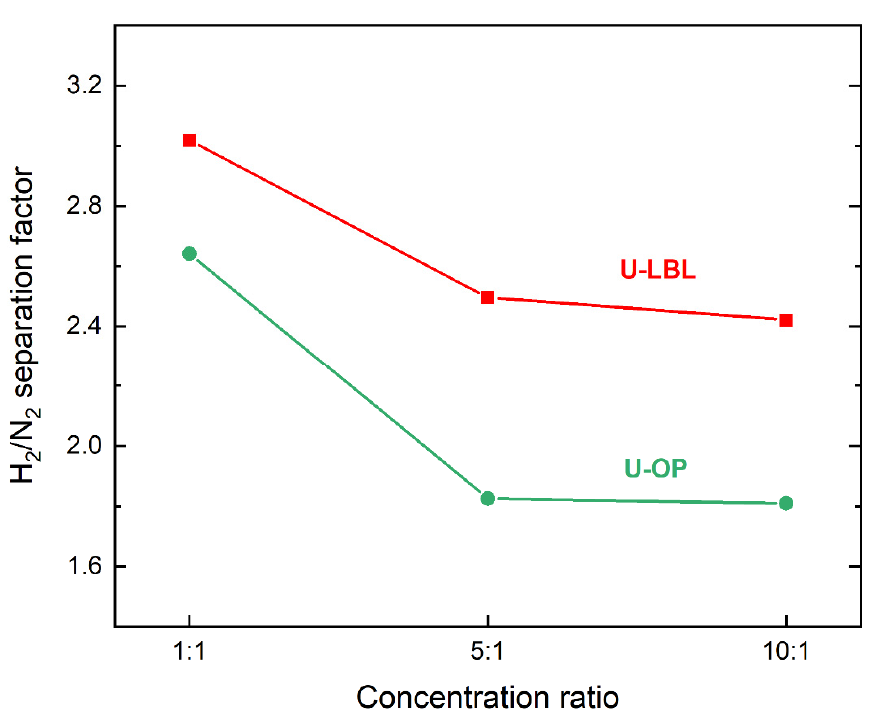
Figure 8. H 2 /N 2 separation factors of the membranes in the three concentration ratios of 1:1, 5:1, and 10:1.